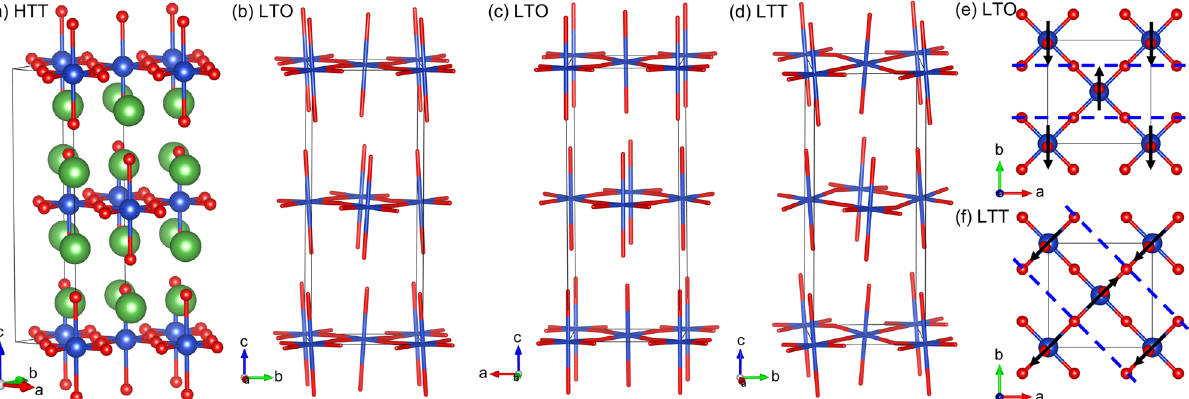
Figure 1. ( a ) Representation of the HTT structure of the Ruddlesden-Popper n = 1 cuprates, packed according to the low-temperature supercell and showing its relationship to the I 4/ mmm aristotype unit-cell (for LTO and LTT, a = a HTT − b HTT , b = a HTT + b HTT and c = c HTT ); A -site cation ( e.g. , La, Ba,…) in green, copper ( B -site) in blue and oxygen in red. ( b ) and ( c ) show representations of the LTO structure ( A -site cations omitted for clarity) viewed just off ( a ) and ( b ), respectively. ( d ) Presents a similar depiction of the LTT phase viewed just off ( a ). Note how, in LTO ( b , c ), the sense of the distortion is such that they propagate solely along ( b ) and all Cu–O–Cu bonds are buckled while, in the LTT phase ( d ), distortions propagate along alternating diagonals in adjacent layers, [1 1 0] at z = 0 and [1 −1 0] at z = 0.5 with respect to the super-cell, and so buckle only half the Cu–O–Cu bonds, along orthogonally alternating vectors in each layer. ( e ) and ( f ) show the CuO 6 octahedra in the ab planes of the LTO and LTT phase, respectively, viewed parallel to ( c ); black arrows depict the direction in which the tilts occur, i.e. , their ‘sense’, and the blue dashed lines the associated ‘buckles’ in the CuO 2